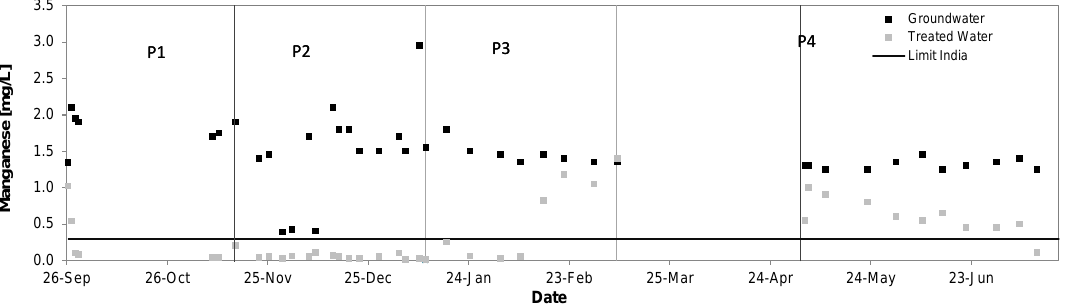
Figure 11. Manganese removal performance of the Kalyani pilot system September 2016–July 2017.